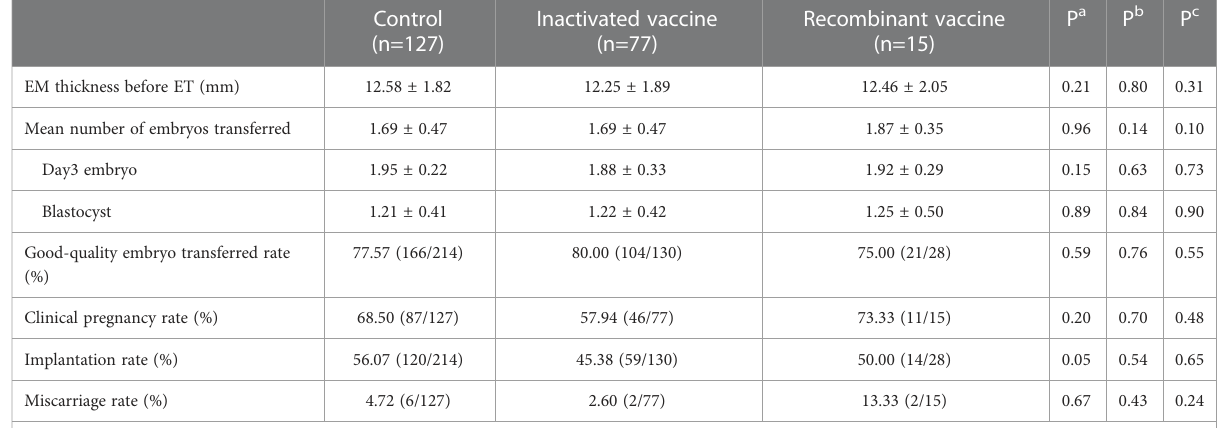
TABLE 3 Pregnancy outcomes in women received embryo transfer.